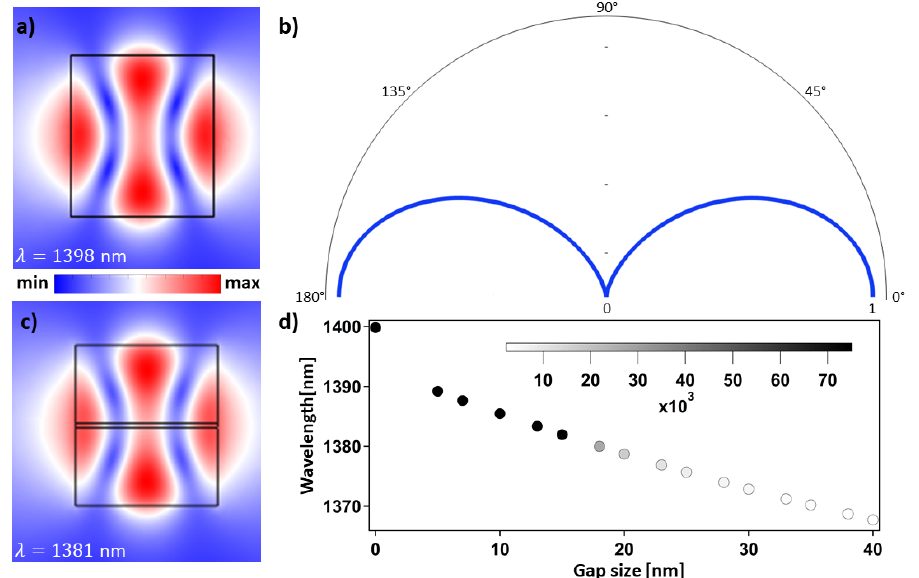
Figure 2. Calculated eigenmodes by modal analysis for an isolated cylinder ( a ) and two suspended isolated cylinders separated by a 15 nm gap ( c ). The cylinder radius is 250 nm, the single disk height is 563 nm and the double disk height is 274 nm. Each field is normalized to the corresponding maximum value. ( b ) Electric far-field magnitude of the isolated cylinder associated with the mode in ( a ). ( d ) Eigenmode wavelength as a function of the gap size in a metasurface with periodicity 850 nm. We choose the periodicity in such a way that the resonant frequency of the isolated and periodic double disk geometries are similar. The color scale represents the quality